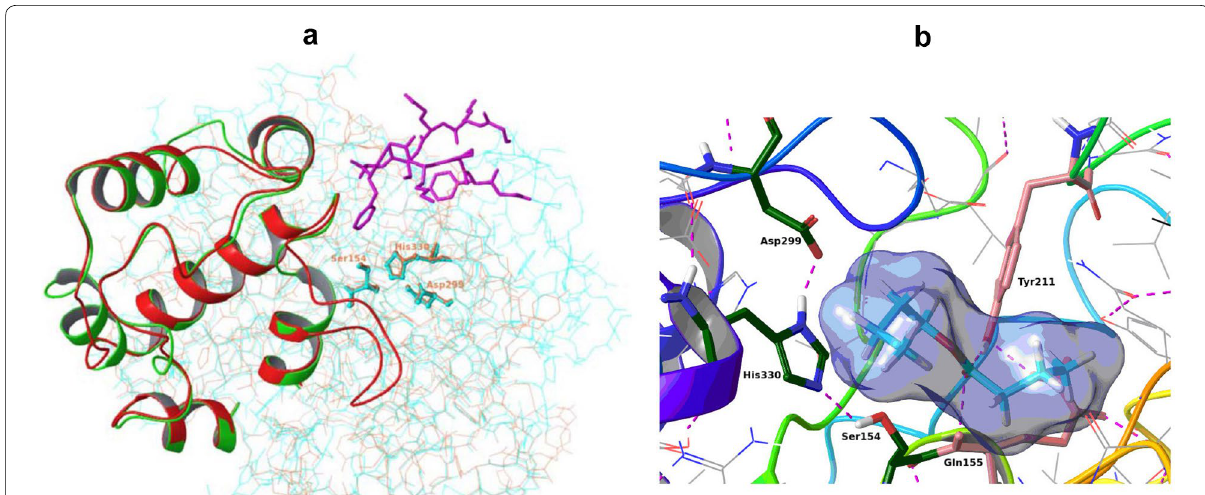
Fig. 3 Structural depiction of LipSm. a Superimposition of 3D‑structures of CALA (turquoise) and LipSm (brown) indicating their catalytic triads (S 154 , D 299 , H 330 ; LipSm numbering) and highlighting both their lid domains, with green and red colors for CALA and LipSm, respectively, whereas in purple is shown the additional active‑site flap of CALA (E 426 up to E 436 ) that LipSm lacks. b ES complex of LipSm with the substrate butyl‑butyrate, where are illustrated the catalytic triad of LipSm, and its conserved residues Q 155 and Y 211 , which form the Y‑type oxyanion hole of LipSm. The hydro‑ gen bonds are illustrated as purple dotted lines